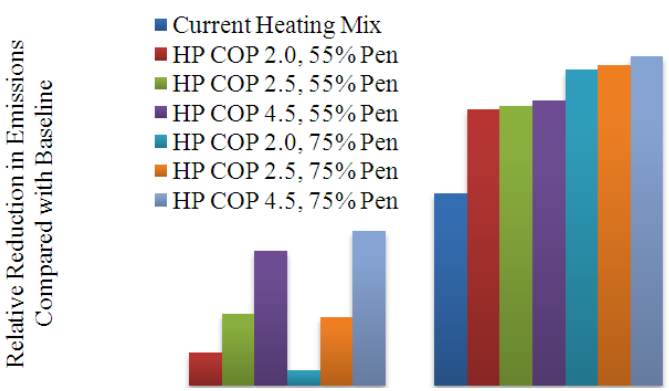
Figure 7. Emissions reduction at different electricity grid emissions factors, heat pump efficiencies and penetration levels.